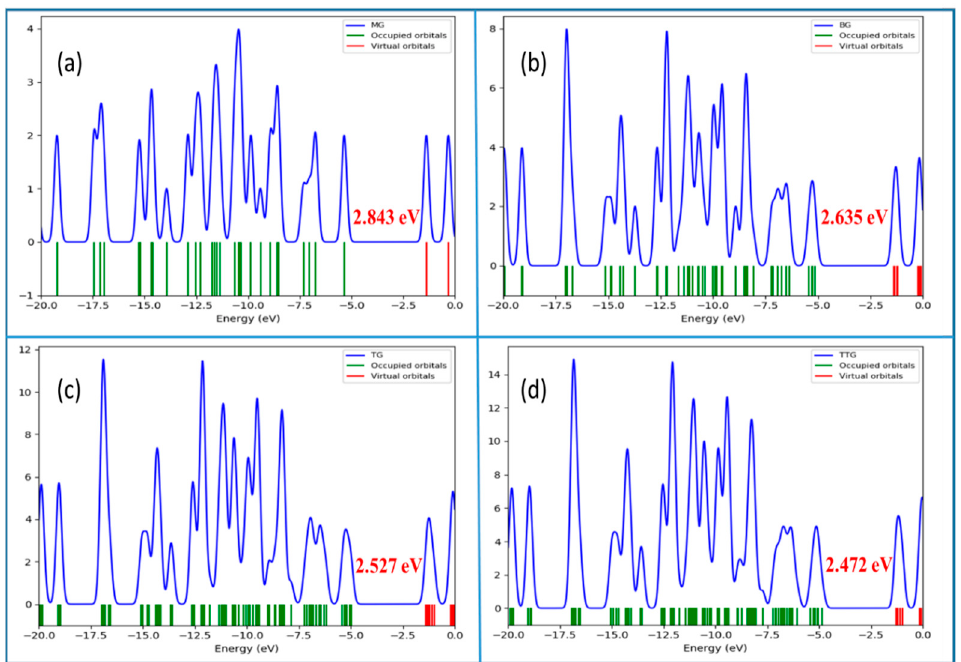
Figure 7. Partial density of states (PDOS) plots of ( a ) MG ( b ) BG, ( c ) TG, and ( d ) TTG. Natural bond orbitals (NBO) population analysis was conducted to estimate the charge transfer in the complexes and is presented in Figures S13 and S14. As shown in Table 1, the complexes exhibit σ donation between the graphene sheets and the B 3+ ion, and π back-donation from the B 3+ ion to the vacant orbitals of the graphene atoms. The NBO results likewise indicate that the charge transfer is more sensitive to the sum of adsorbed B 3+ ions in 2B 3+ @TG and 2B 3+ @TTG than the other complexes, suggesting greater stability